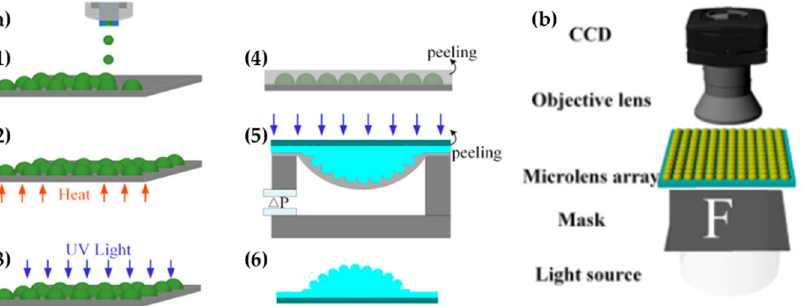
Figure 14. ( a ) The schematic diagram of the fabrication process of an artificial compound eye. ( b ) The schematic setup of the optical system for the measurement. Adapted with permission from [48]. Copyright (2020) American Chemical Society.